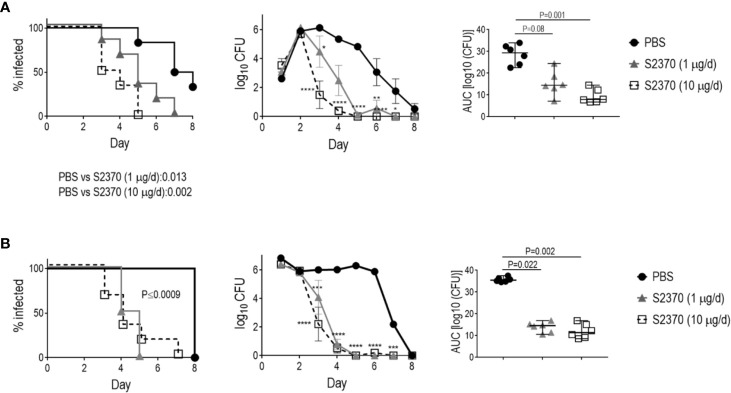
Efficacy of S2370 against N. gonorrhoeae H041 in human FH/C4BP transgenic mice. Premarin®-treated 6- to 8-week-old human FH/C4BP transgenic mice (n = 6/group) were infected with either 106 CFU (A) or 107 CFU (B)
N. gonorrhoeae strain H041. Mice were treated daily (starting 2 h before infection) intravaginally either with PBS (vehicle control) or with 1 µg or 10 µg of FH*/Fc molecule S2370. Left graphs: Kaplan Meier curves showing time to clearance, analyzed by the Mantel-Cox (log-rank) test. Significance was set at 0.017 (Bonferroni’s correction for comparisons across three groups). Middle graphs: log10 CFU versus time. X-axis, day; Y-axis, log10 CFU. Comparisons of the CFU over time between each treatment group and the respective saline control was made by two-way ANOVA and Dunnett’s multiple comparison test. *P < 0.05; **P < 0.01; ***P < 0.001; ****P < 0.0001. Right graphs: bacterial burdens consolidated over time (area under the curve [log10 CFU] analysis). The three groups were compared by one-way ANOVA using the non-parametric Kruskal-Wallis equality of populations rank test. The χ2 with ties were 12.12 (P = 0.0002) and 11.94 (P = 0.0002) for the graphs in panels (A, B), respectively. Pairwise AUC comparisons across groups was made with Dunn’s multiple comparison test.